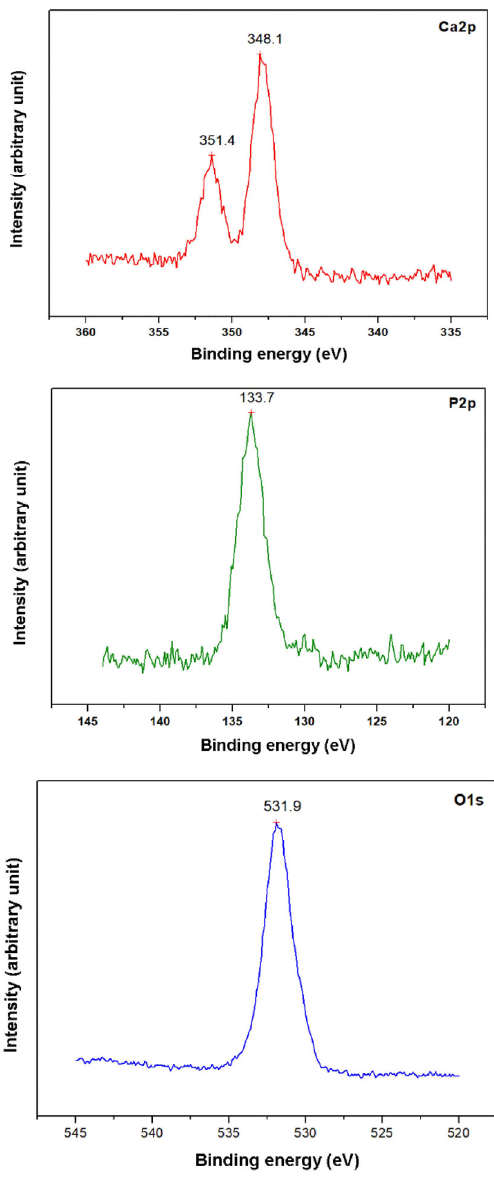
Fig. 9 Ca2p, P2p, and O1s XPS narrow spectra of ATF-A tribofilm.